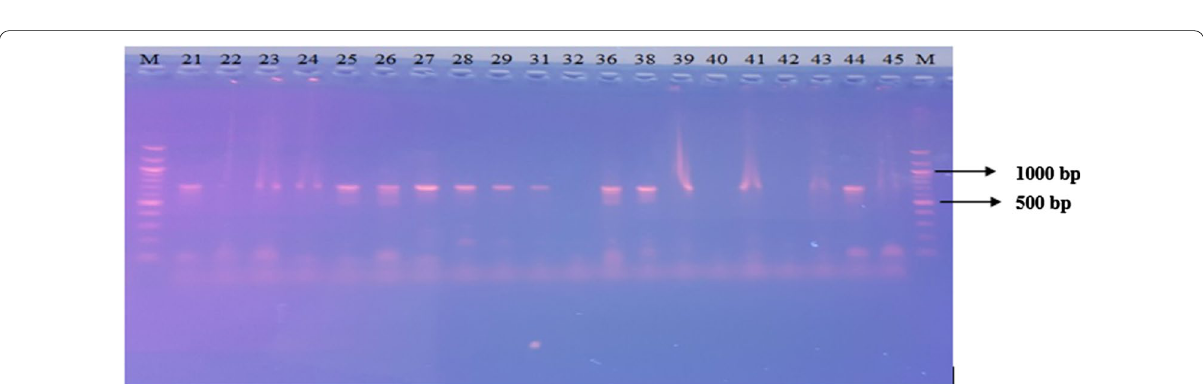
DNA markers (size 100 bp), 1–20: Mosquito samples =